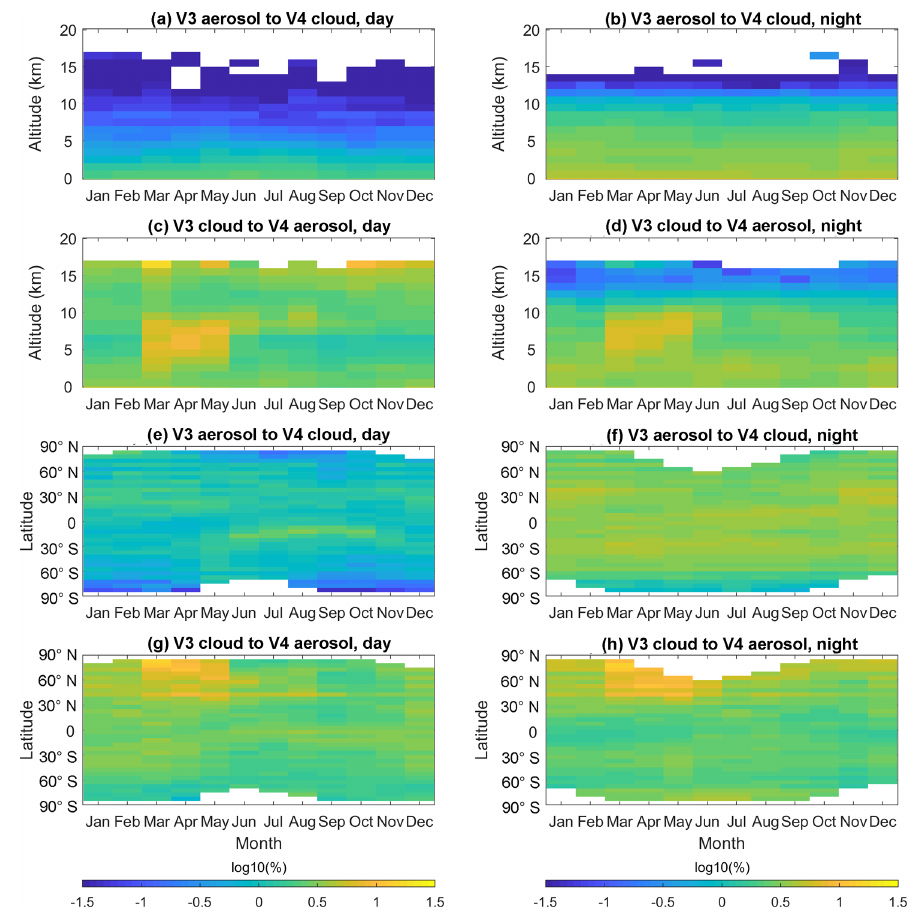
Figure 16. Seasonal distributions of fractional changes of V3 aerosol to V4 cloud or V3 cloud to V4 aerosol as a function of altitude (a–d) and latitude (e–h) ( c , day; d , night), and seasonal variations in latitudinal changes of version 3 aerosol switching to version 4 cloud ( e , day; f , night), version 3 cloud switching to version 4 aerosol ( g , day; h ,